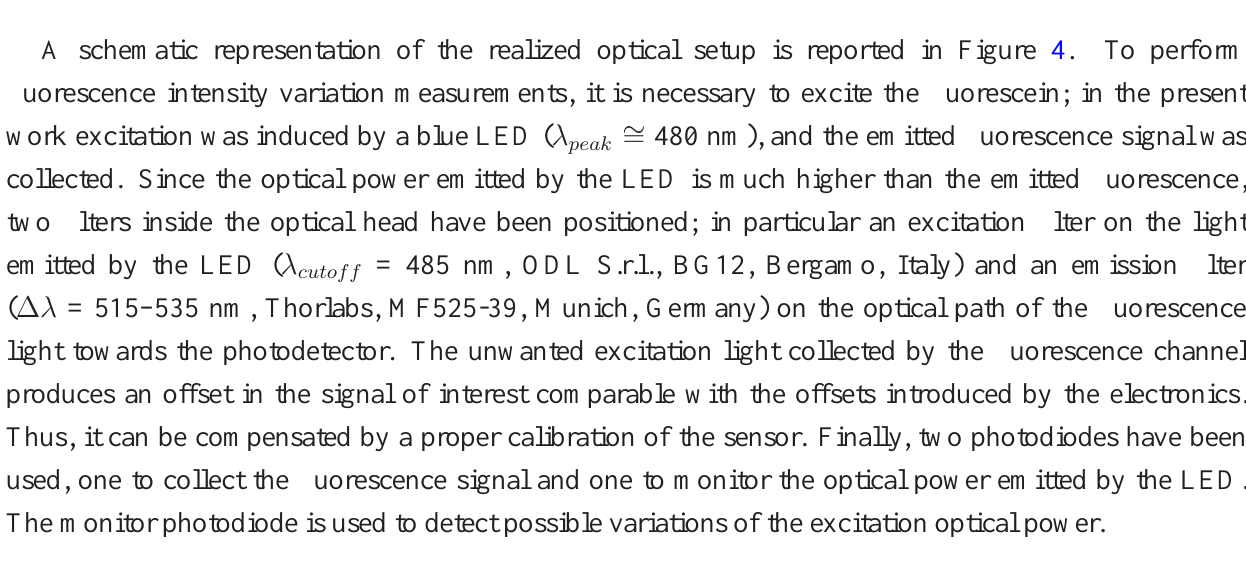
Figure 4. Schematic representation of the optical setup realized to perform fluorescence intensity measurements. It consists of a blue LED to excite the fluorescein, two optical filters (an excitation and an emission filter respectively) and finally two photodiodes, one to collect the fluorescence signal and one to monitor the optical power emitted by the